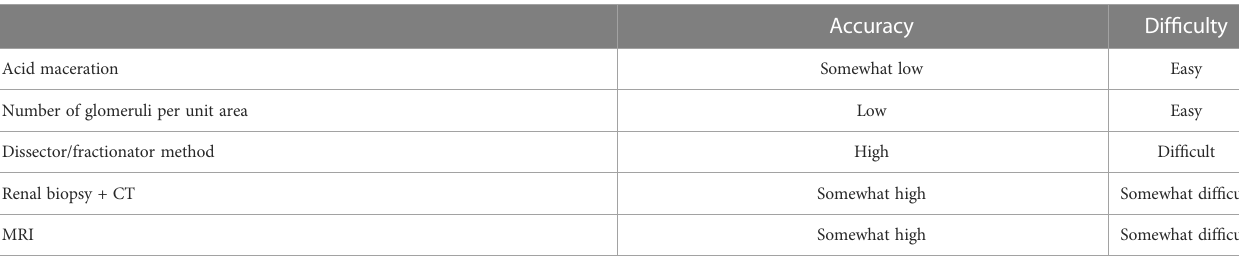
TABLE 2 Methods of determining the glomerular